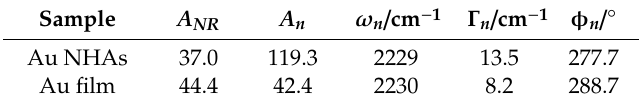
Table 1. Parameters of the SFG spectra on Au NHAs and flat Au